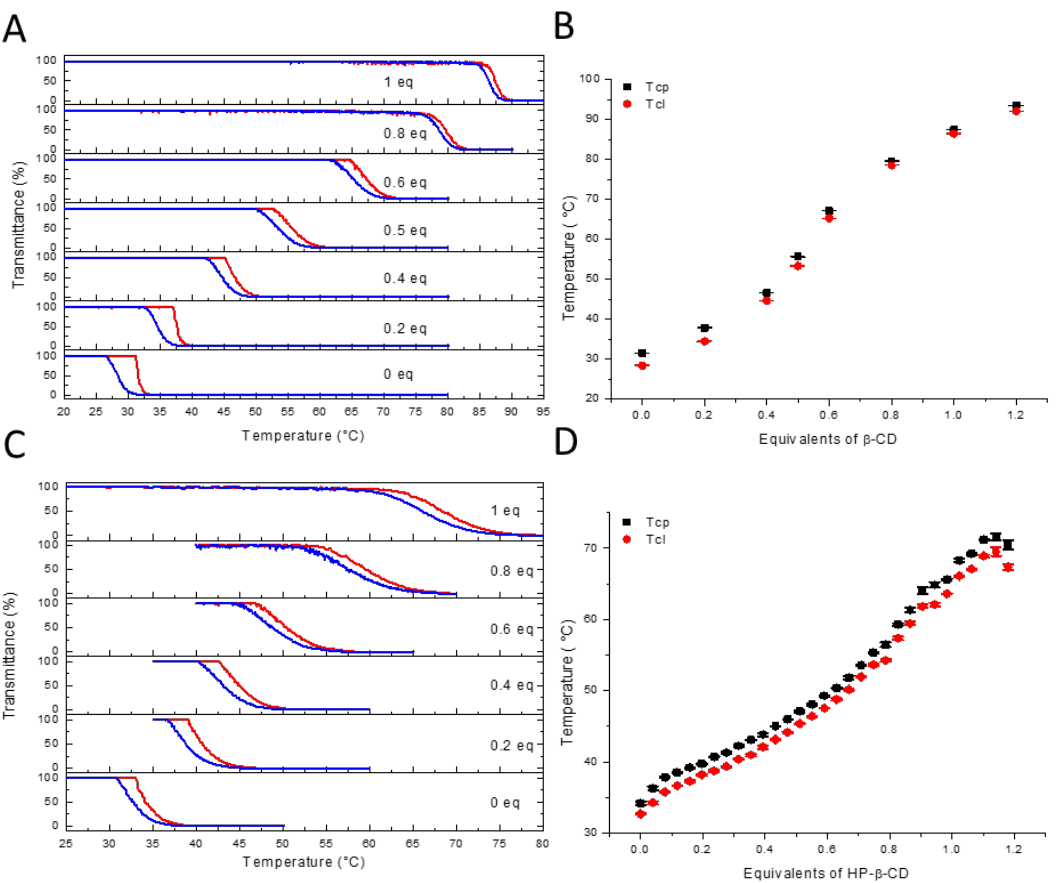
Figure 3. ( A ) Stacked turbidimetry plots of a 10 mg/mL solution of P(EtOx-stat-AdamantanOx) with a varying β -CD content, showing heating and cooling curves in red and blue, respectively. ( B ) Observed T cp and T cl as a function of the β -CD content for a 10 mg/mL solution of P(EtOx-stat-AdamantanOx) with error bars (n = 3). ( C ) Stacked turbidimetry plots of a 5 mg/mL solution of P(EtOx-stat-AdamantanOx) with a varying HP- β -CD content. ( D ) Observed T cp and T cl as a function of HP- β -CD content for a 5 mg/mL solution of P(EtOx-stat-AdamantanOx) with error bars (n = 3).